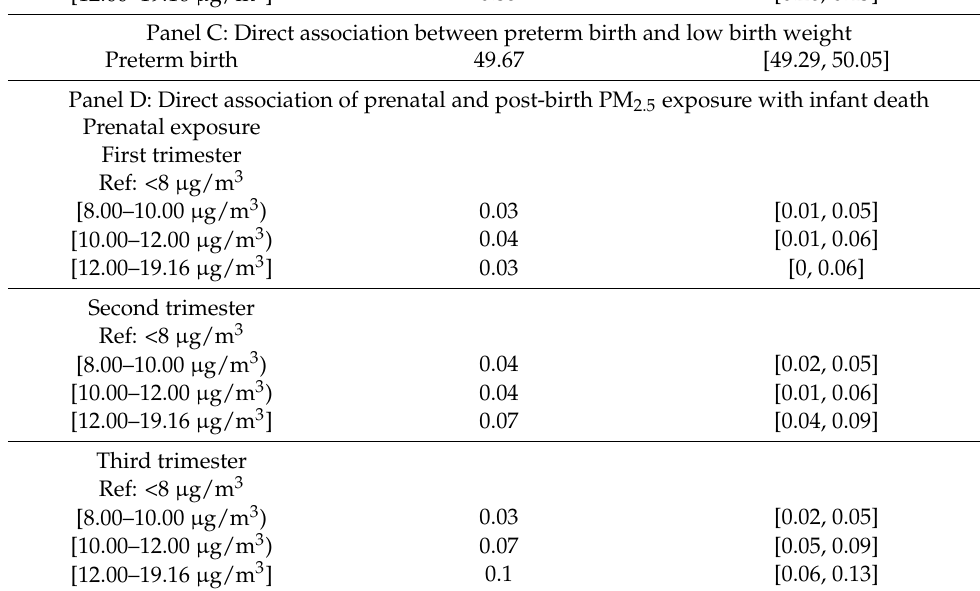
Panel C: Direct association between preterm birth and low birth weight Preterm birth Panel D: Direct association of prenatal and post-birth PM 2.5 exposure with infant